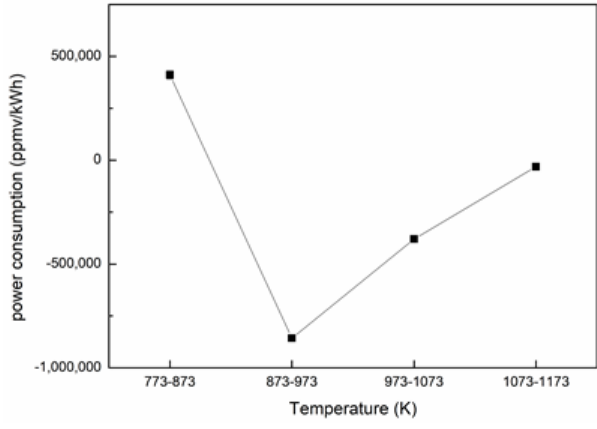
ff erent temperature